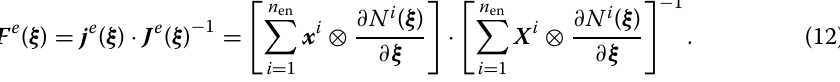
Fig. 3 Discretized setting with the reference element B (cid:2) , material element B e